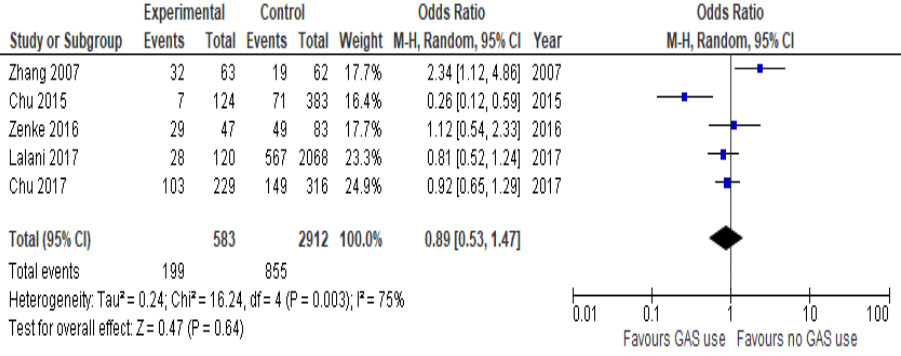
Figure 4. Forest plot for overall response rate of the analyzed studies.